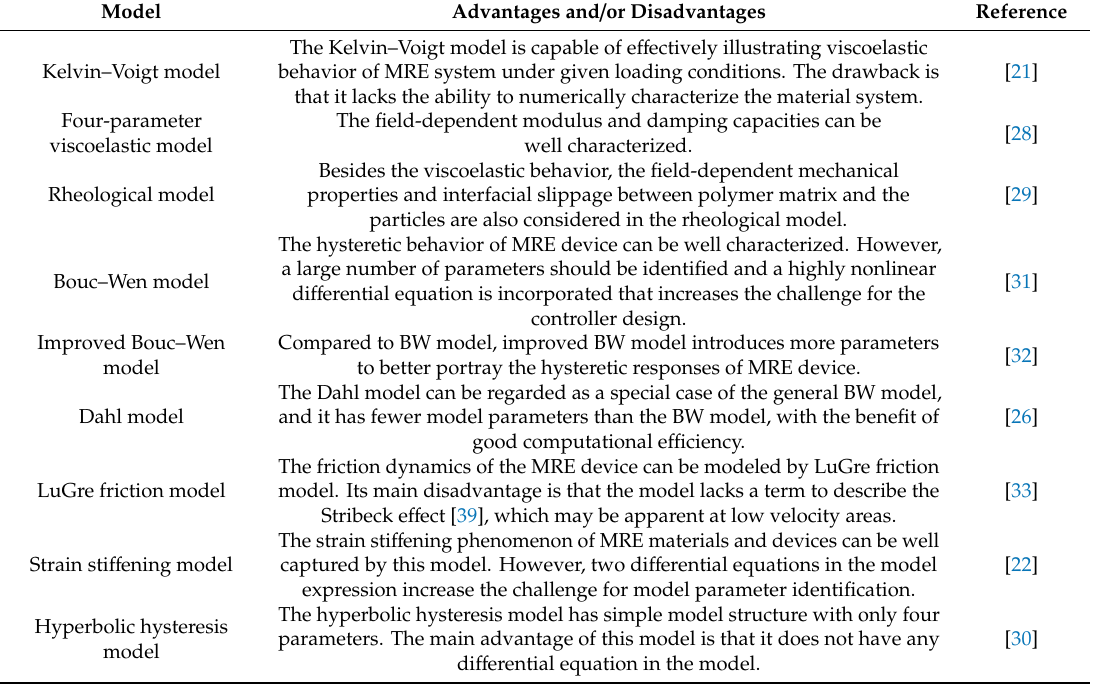
Table 1. Summary of phenomenological models of MRE materials /